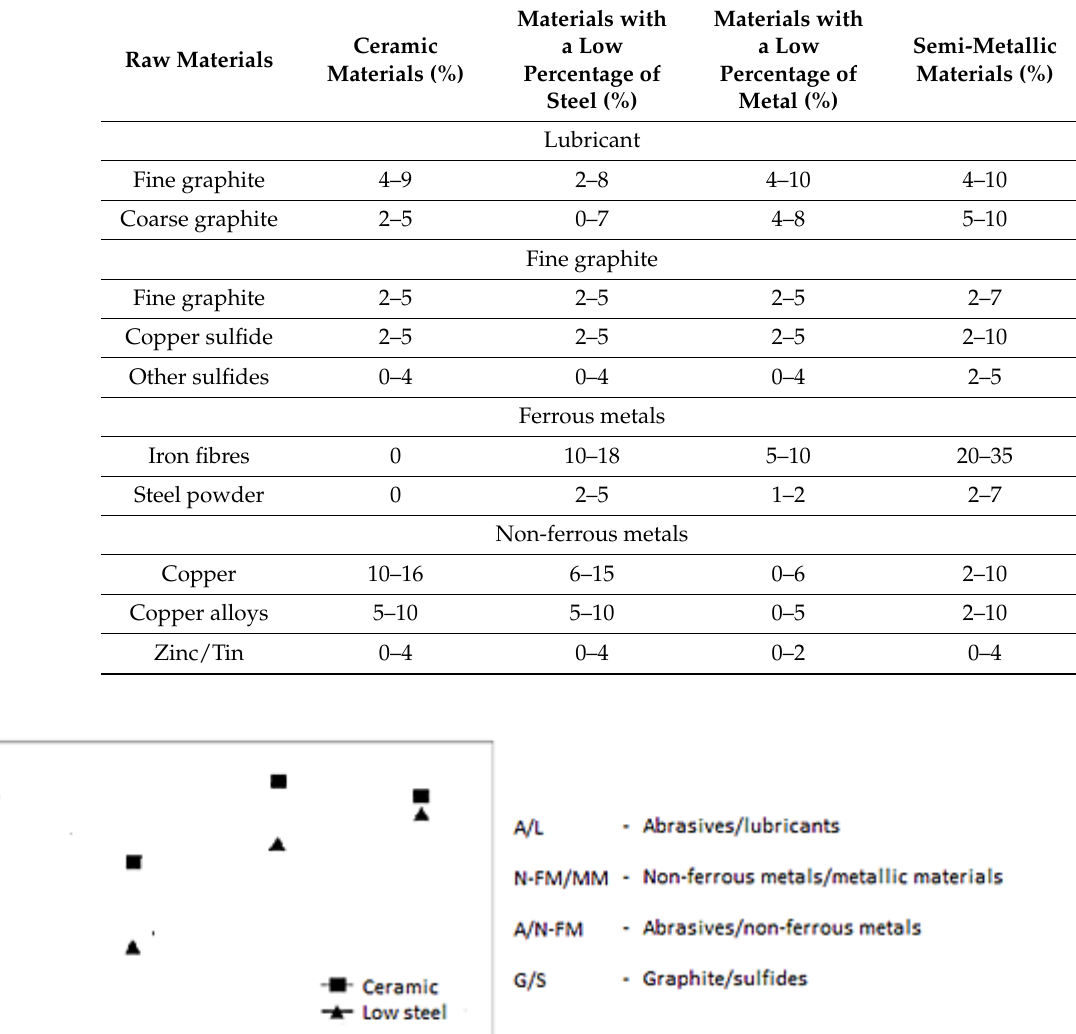
Table 2. Lubricants and metals percentage in non-organic asbestos materials (reprinted/adapted with permission from ref. [21]. 2022, Elsevier).